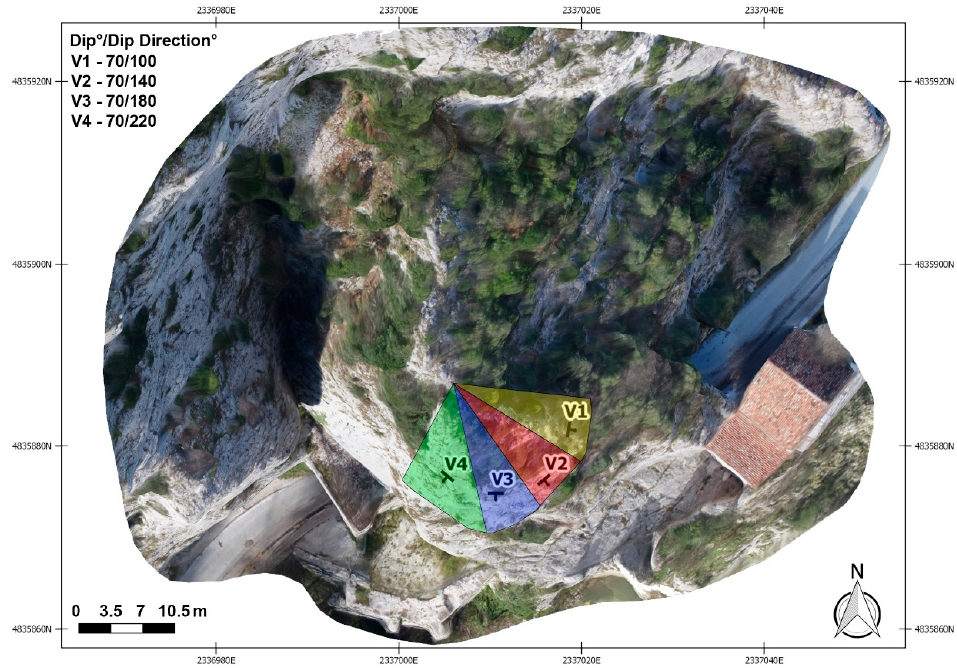
Figure 3. Different slope directions identified and used for the kinematic stability analysis; orthophoto from thee UAV survey in the background.